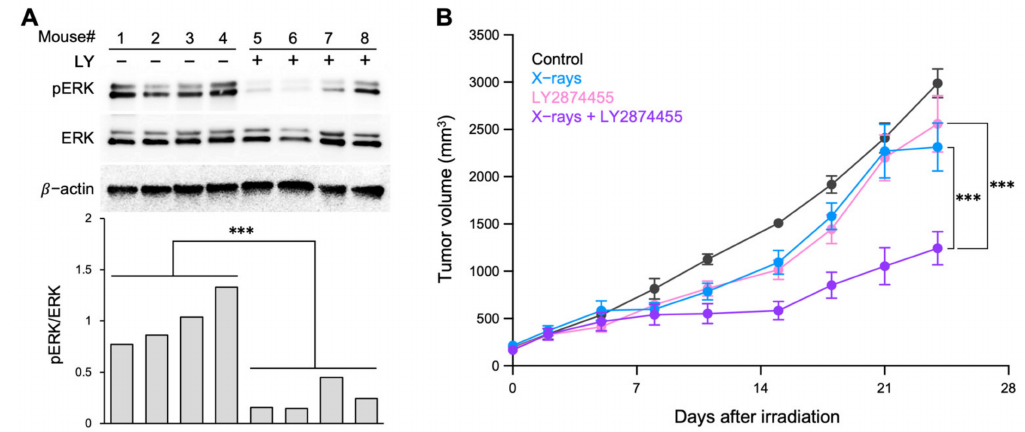
Figure 4. Radiosensitizing effects of LY2874455 in a nude mouse xenograft model. Mice received oral LY2874455 (3 mg/kg body weight) once daily for 7 consecutive days (i.e., Day 1–7). One hour after the first drug administration, tumors were irradiated with X-rays (10 Gy). ( A ) Immunoblots showing suppression of ERK phosphorylation by LY2874455. A549 tumor xenografts were resected from LY2874455-treated or -untreated mice 12 h after the second drug administration ( n = 4 per group). pERK, phosphorylated ERK. The lower panel shows the quantitation of the immunoblots shown in the upper panel; the ratio of pERK to ERK is shown after normalizing to β -actin. ***, p < 0.001 (Mann–Whitney U-test). ( B ) Growth of A549 tumor xenografts (mean ± s.e.m., n = 6). ***, p < 0.001 (ANCOVA test, followed by a post-hoc pairwise comparison test). IR, X-rays (10 Gy); LY, LY2874455 (3 mg/kg body